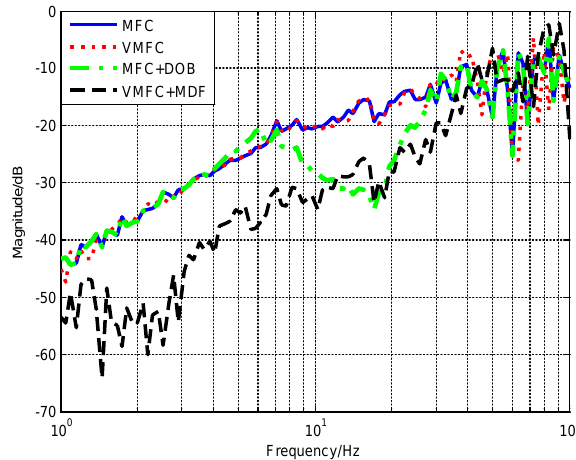
Figure 14. Comparison of disturbance suppression abilities between the MFC with DOB and the VMFC with MDF in frequency domain.